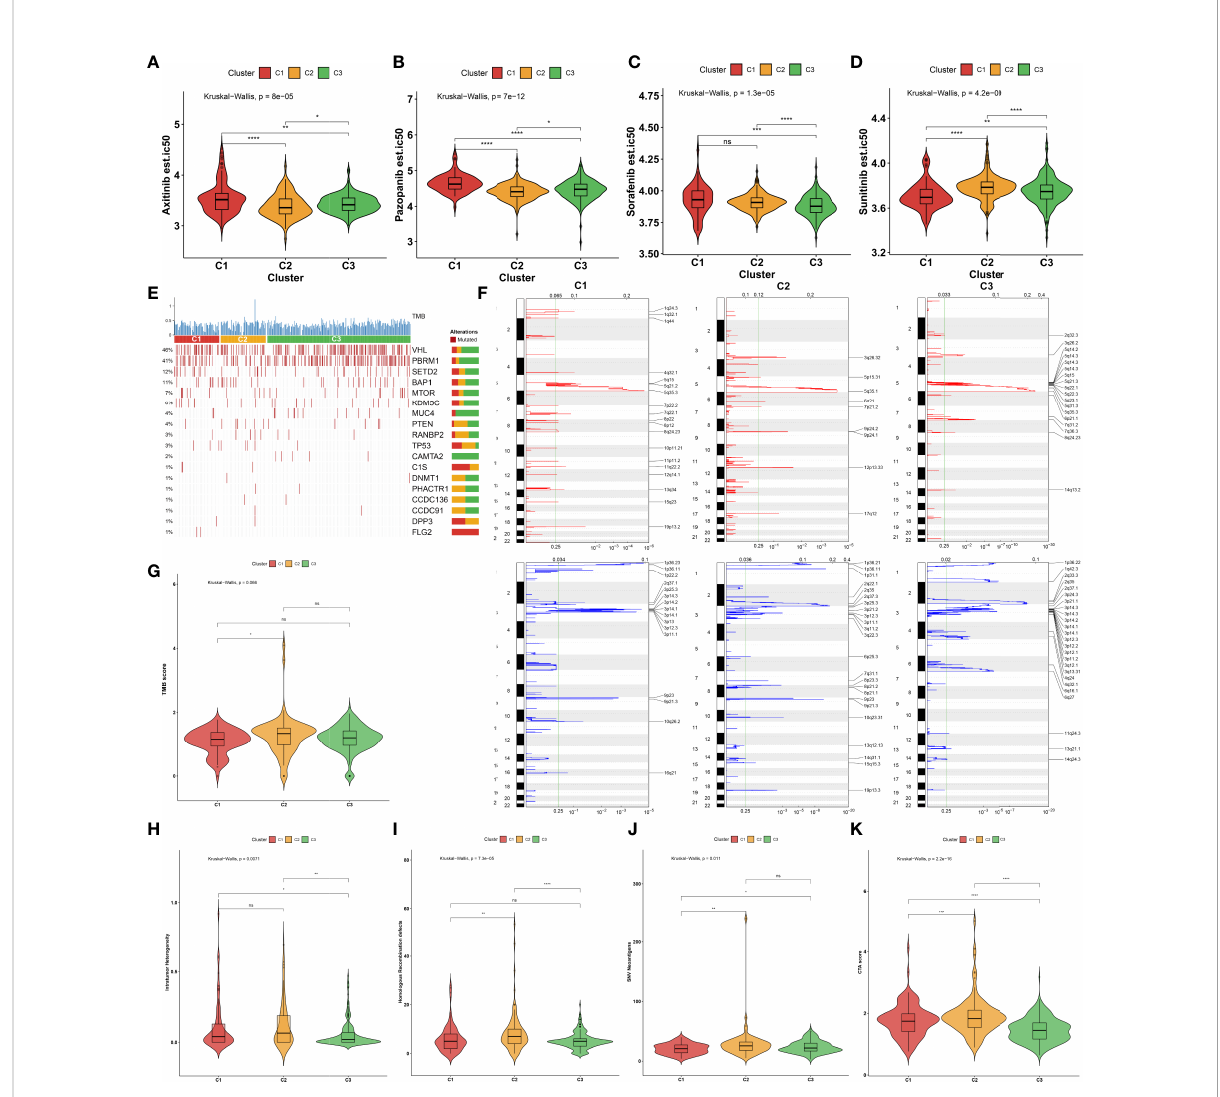
FIGURE 4 Sensitivity to known targeted drugs, genomic alterations, and intrinsic immune evasion mechanisms of the three aging phenotypes in the TCGA-KIRC cohort. (A – D) Box plots of the differences in sensitivity to (A) axitinib, (B) pazopanib, (C) sorafenib, and (D) sunitinib across the three aging phenotypes. (E) Waterfall plot of tumor somatic mutation across the three aging phenotypes. The top bar plot shows TMB. Each column represents an individual patient. Numbers and bar graphs depict the mutational frequencies as well as the proportions of mutation types. (F) Somatic copy number alterations across the three aging phenotypes. The y -axis indicates the chromosome positions, while the x -axis depicts the focal deletion or ampli fi cation identi fi ed by a horizontal blue or red bar. The green line indicates the signi fi cance threshold of FDR <0.25. ( G – K ) Box plots of the differences in (G) TMB score, (H) intratumor heterogeneity, (I) homologous recombination defects, (J) SNV neoantigens, and (K) CTA score across the three aging phenotypes. Ns, no signi fi cance; * P < 0.05; ** P < 0.01; *** P < 0.001; **** P <